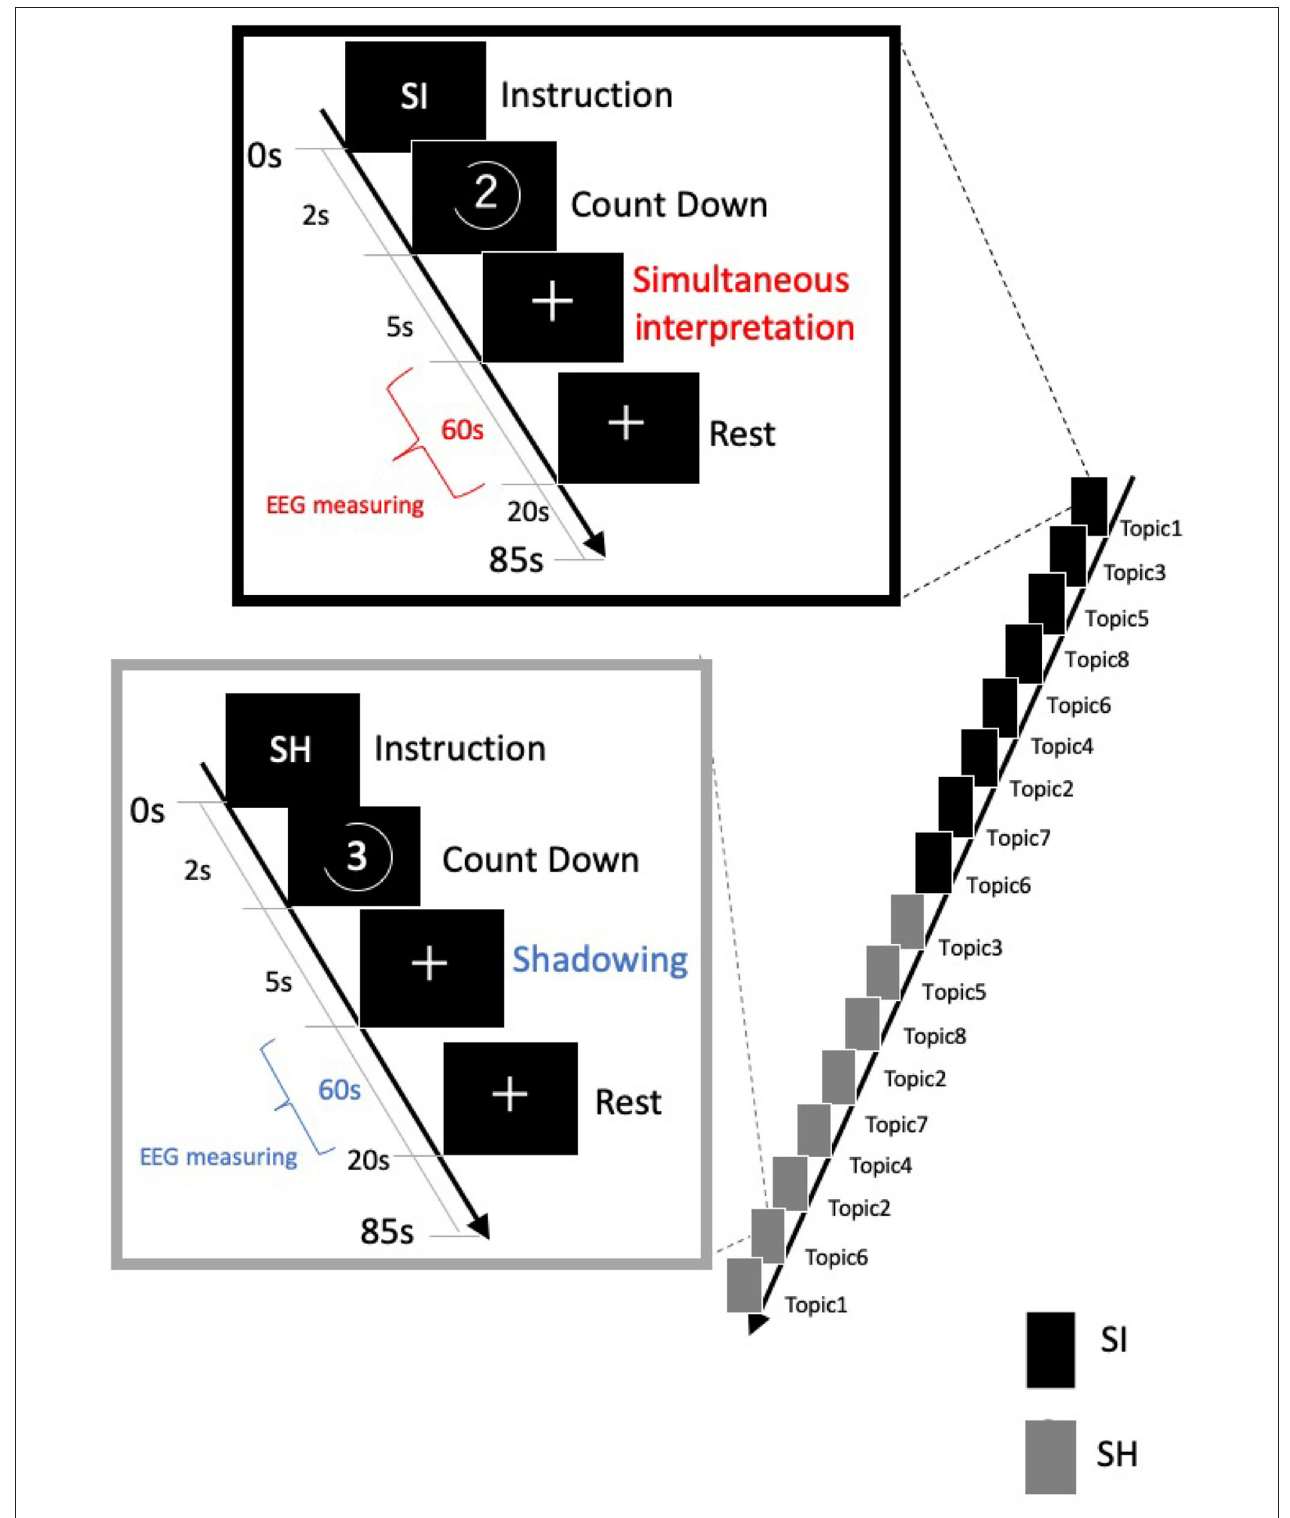
FIGURE 2 | Our task consisted of two conditions: simultaneous translation from Japanese to English [simultaneous interpretation (SI) condition] and shadowing that immediately repeats Japanese [simultaneous shadowing (SH) condition]. Under both conditions, eight 60-s news topic sounds were randomly presented. Identical voice stimuli were used under both